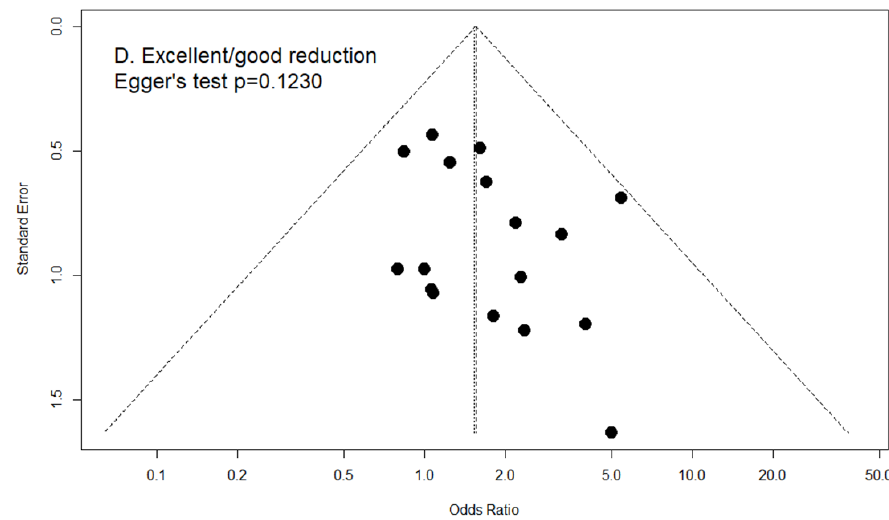
Figure 3. Funnel plots with pseudo 95% confidence intervals of ( A ) ratio of means in operation duration (Egger’s test p = 0.6359); ( B ) ratio of means in amount of blood loss (Egger’s test p = 0.1287); ( C ) odds ratio in number of complications (Egger’s test p = 0.2219); and ( D ) odds ratio in excel- lent/good reduction (Egger’s test p = 0.1230).